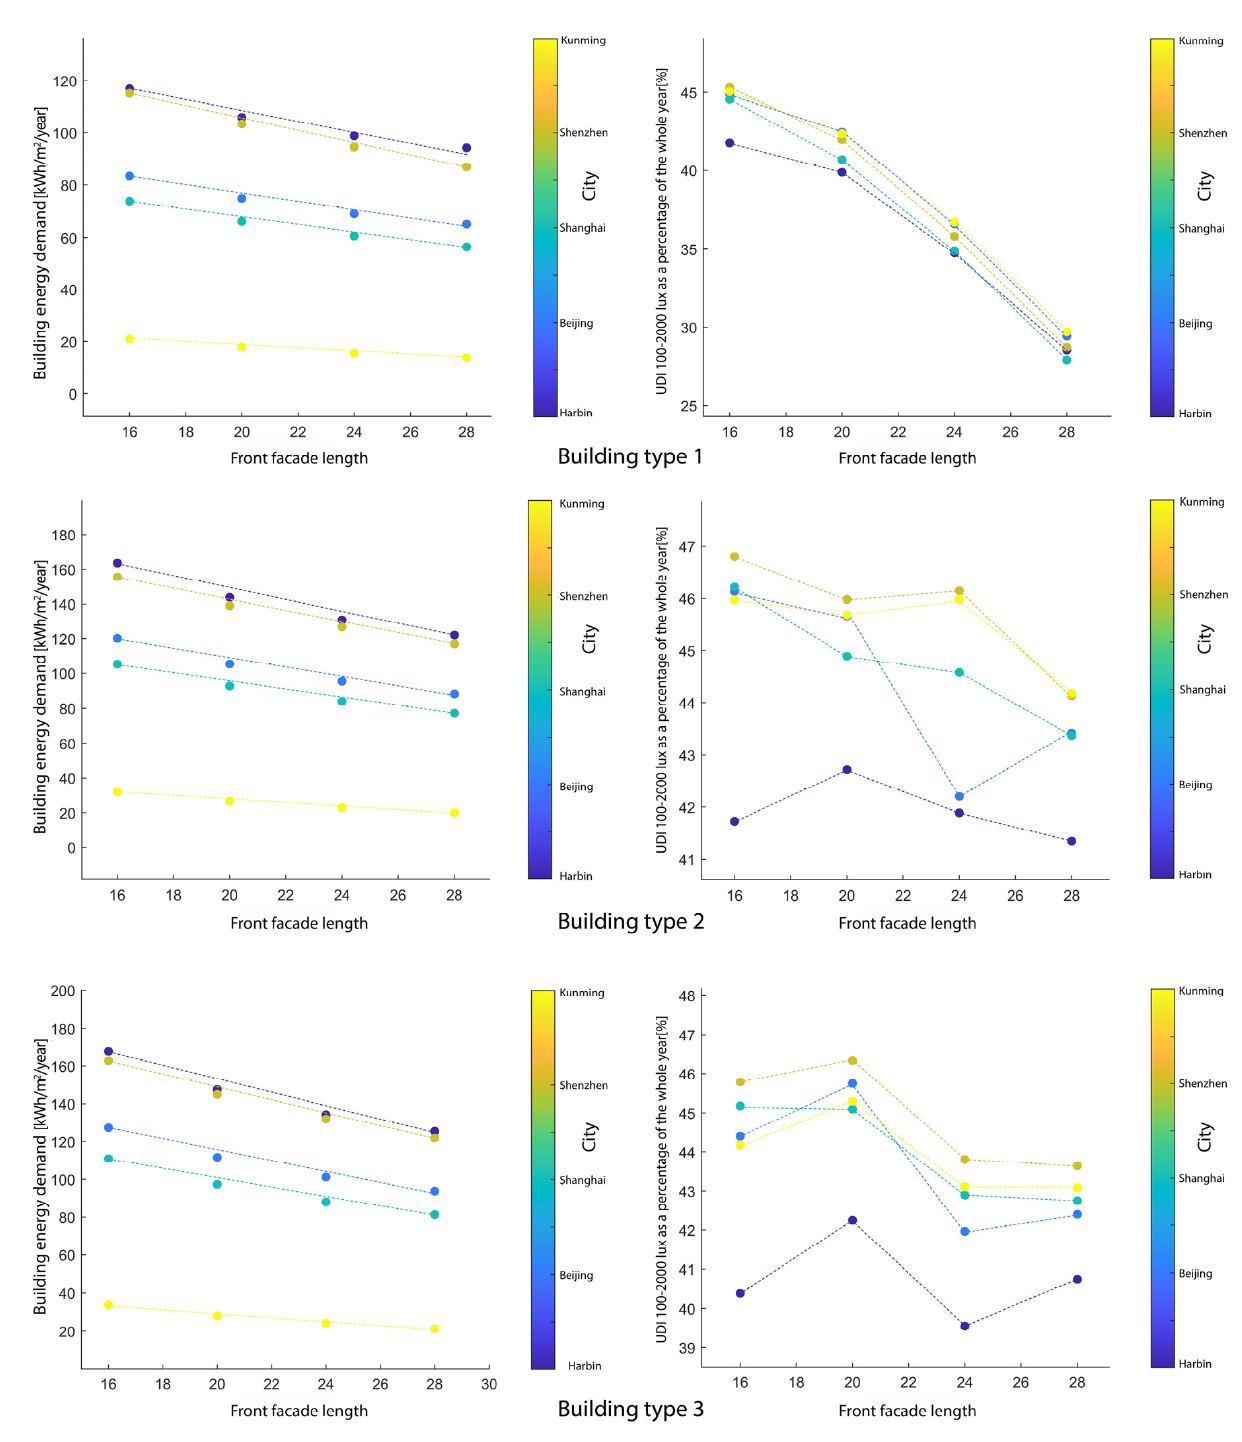
Figure 25. Relationship between the length of the front elevation and the energy demand ( left ) and relationship between the length of the front elevation and lighting environmental comfort ( right ) for three building